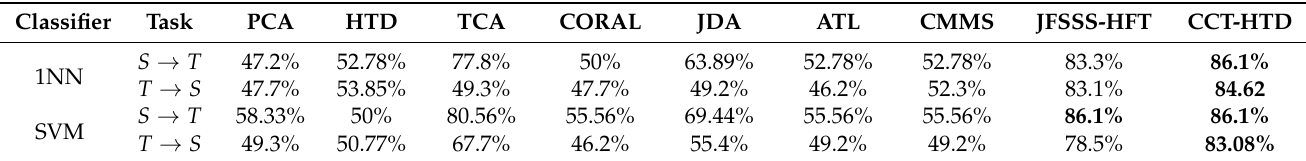
Table 5. Classification accuracies of different domain adaptation methods with 1NN and SVM using dataset 1.